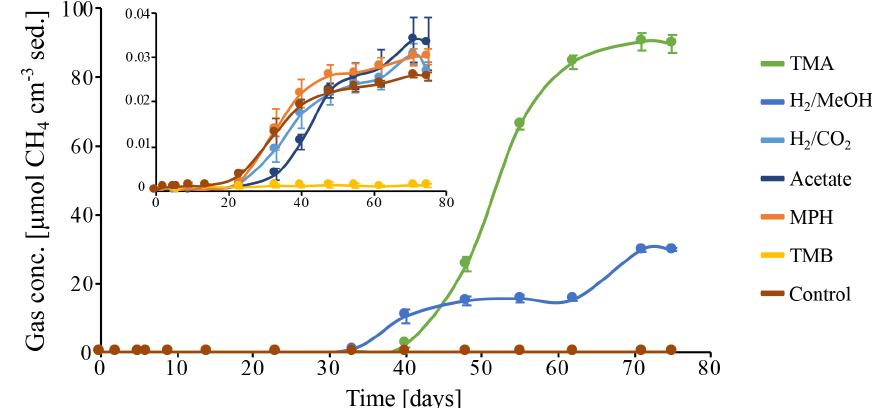
Figure 5. Methane production in batch incubations of peat sediment slurries, in which CH 4 is expressed as CH 4 cm − 3 of original peat sediment over the course of 75d. Substrates: trimethylamine (TMA), hydrogen and methanol (H 2 / MeOH), hydrogen and CO 2 (H 2 / CO 2 ), acetate, methoxyphenol (MPH), trimethoxybenzoate (TMB), and an anaerobic control incubation without substrate amendment (Control). Data points represent the average of triplicate measurements on triplicate incubations. Error bars indicate the standard deviation of the mean. The insert depicts a zoom in on the CH 4 concentrations excluding the incubations on TMA and H 2 / MeOH.